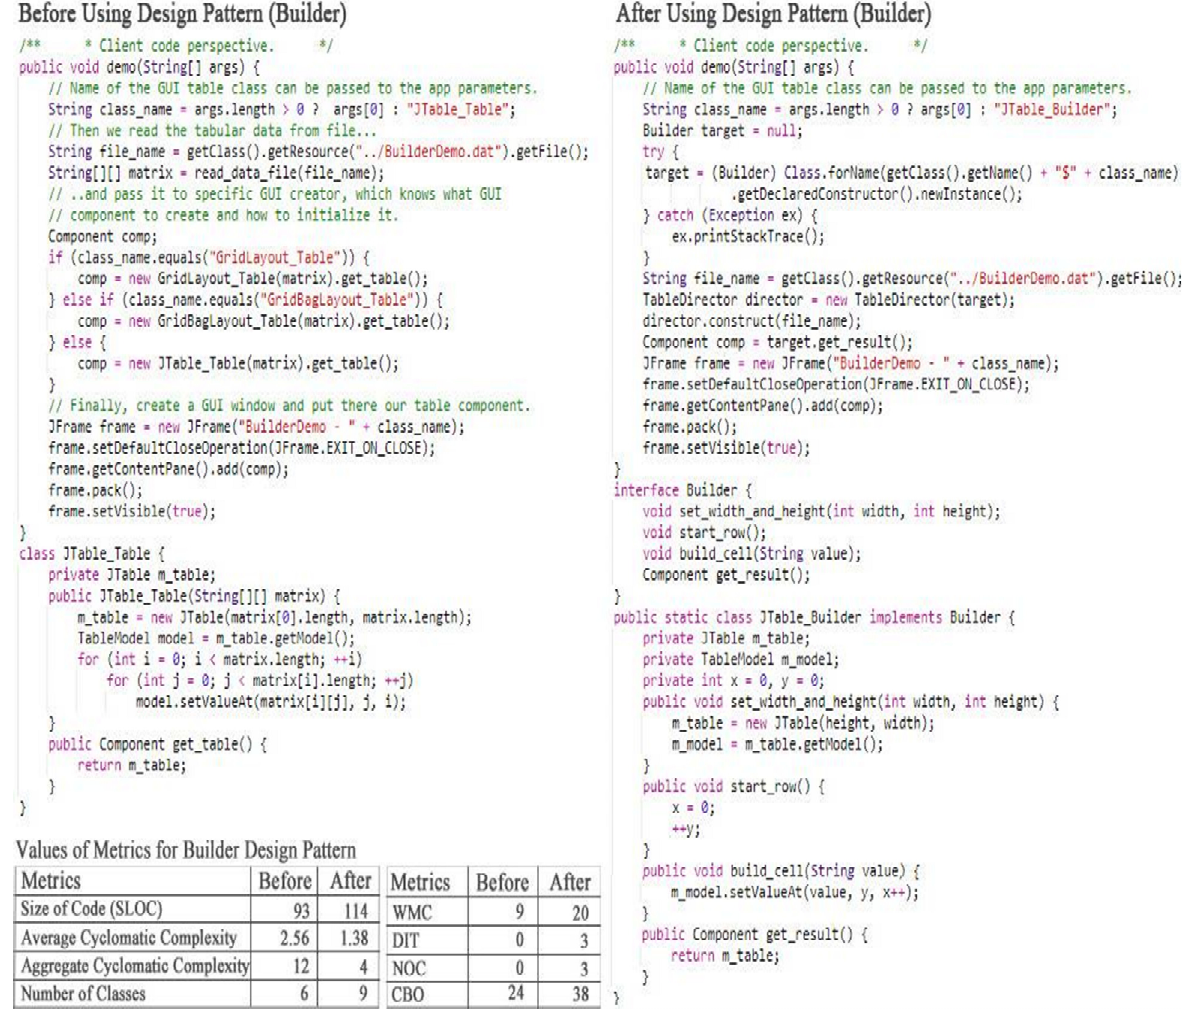
FIG. 2. PART OF BEFORE/AFTER PROGRAM PAIR FOR BUILDER (CODE TAKEN FROM SOURCEMAKING.COM